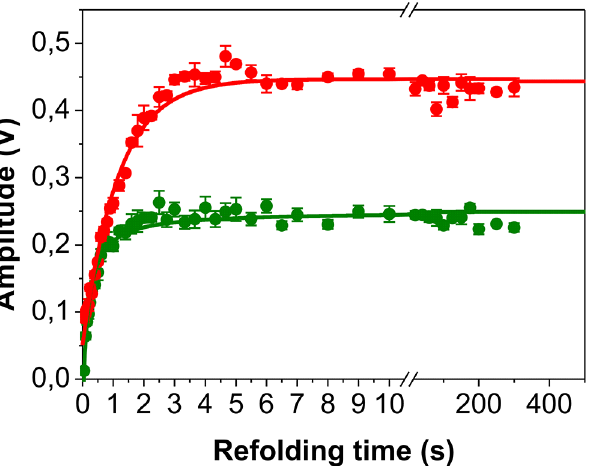
Fig 7. Triple mixing refolding kinetics of N-BAR. The amplitude plot of the triple-jump experiment was monitored by changes in fluorescence. The unfolding to 4 M urea was accomplished manually with a delay time of 15 s ( ± 3 s) followed by a double mixing refolding experiments (N assay). The protein concentration during the refolding time was 2 μ M. Amplitudes from the fast unfolding reaction are labeled with green symbols; amplitudes from the slow unfolding reaction are labeled with red symbols. The fits (same functions as for the N assay but without the very slow exponential decay) are represented by continues lines.